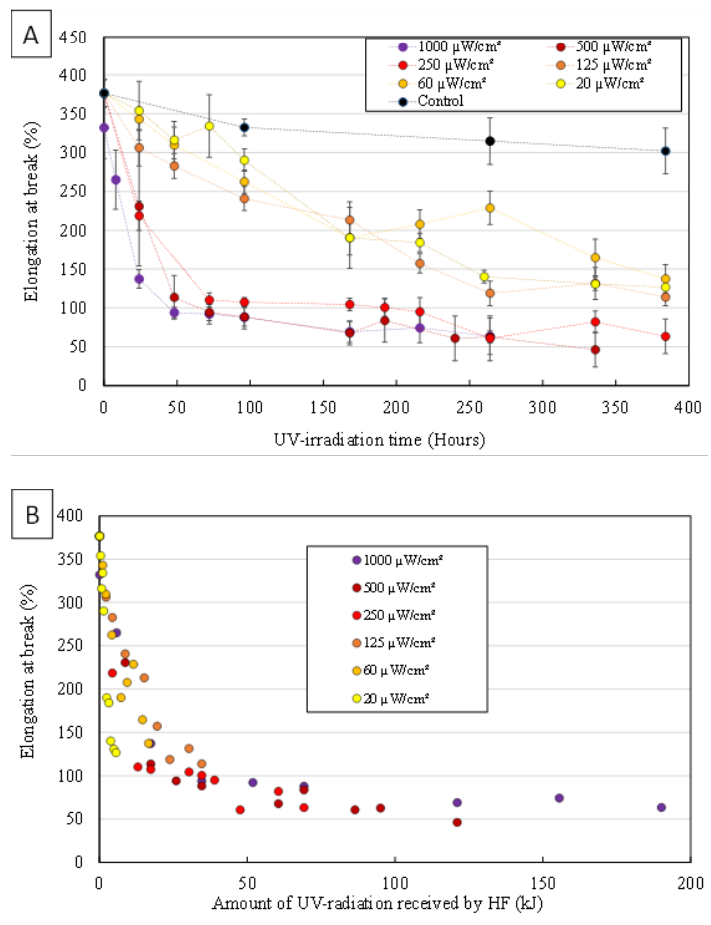
Figure 3. Elongation at break measured on UV irradiated HFs as a function of ( A ) the irradiation time or ( B ) the amount of UV radiation received.